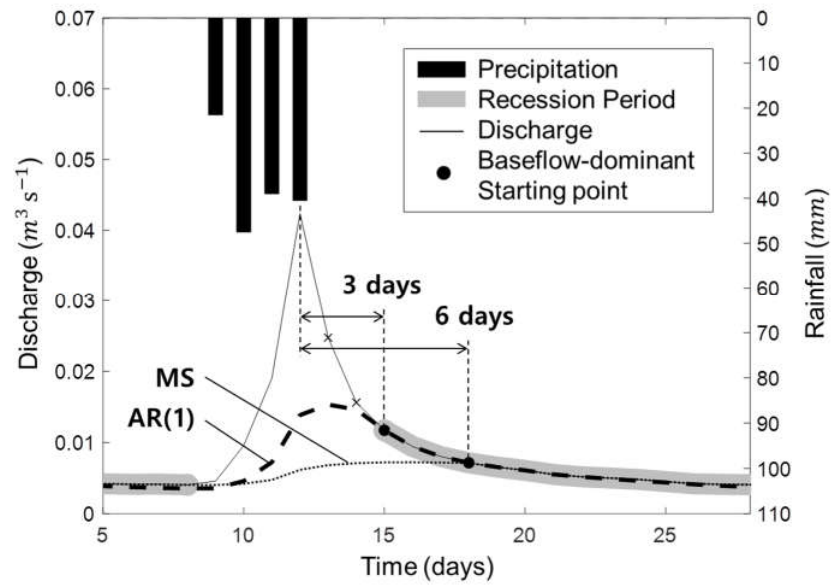
Figure 9. Baseflow separation with the Eckhardt filter [28] from the GD catchment rainfall-runoff data. The baseflow-dominant points where AR(1) model was used started two to three days after the peak flow, whereas points where MS was used stared 6–10 days after the peak flow.